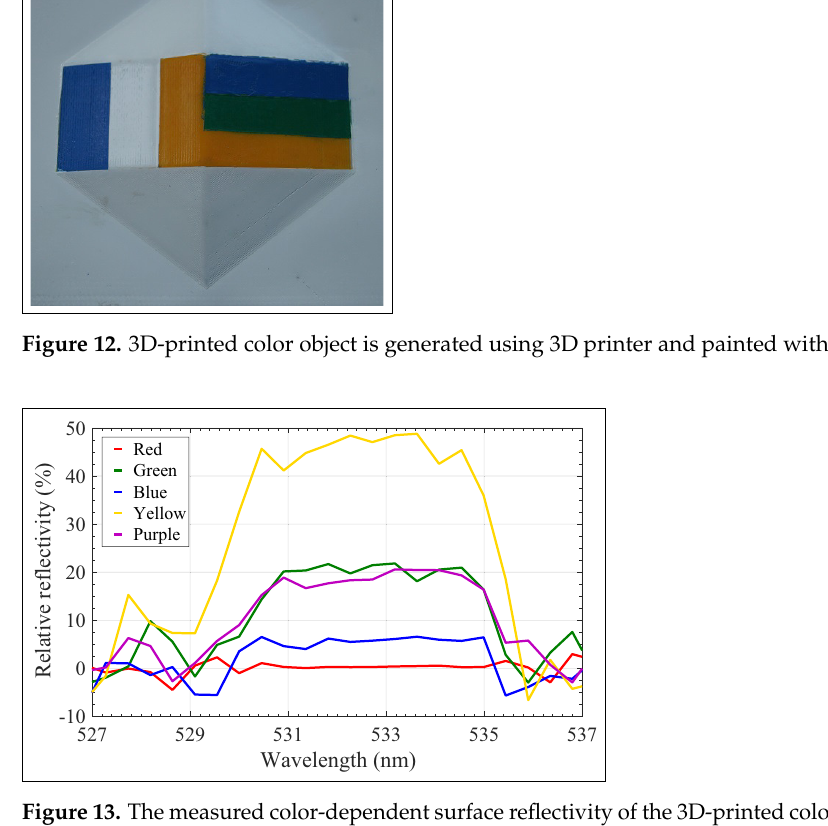
Figure 13. The measured color-dependent surface reflectivity of the 3D-printed color object at 532 nm, while the reflectivity of the white-color paint is assumed to be